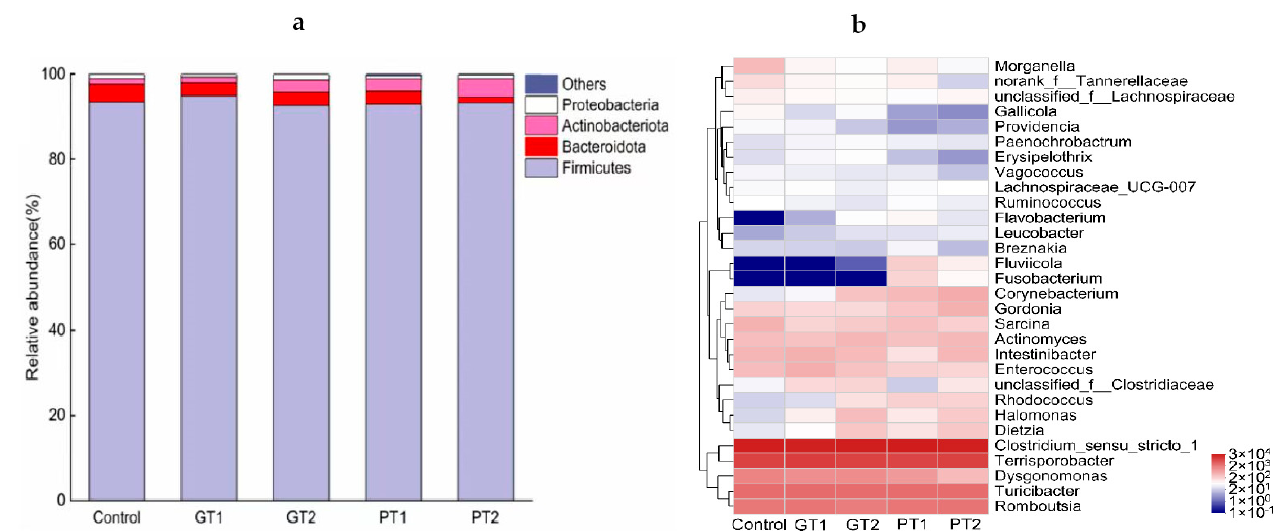
Figure 3. The relative abundances of the constitutive phyla ( a ), and heat maps of genera based on 16S rDNA ( b ) for the control and the GT1, GT2, PT1, and PT2 treatment groups. Bacterial OTUs counted below 1% of the total number of reads were categorized as other.